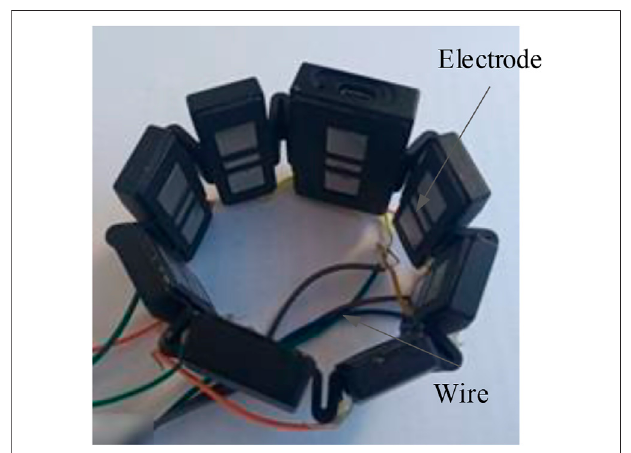
FIGURE 1 | Circumferential electromyography